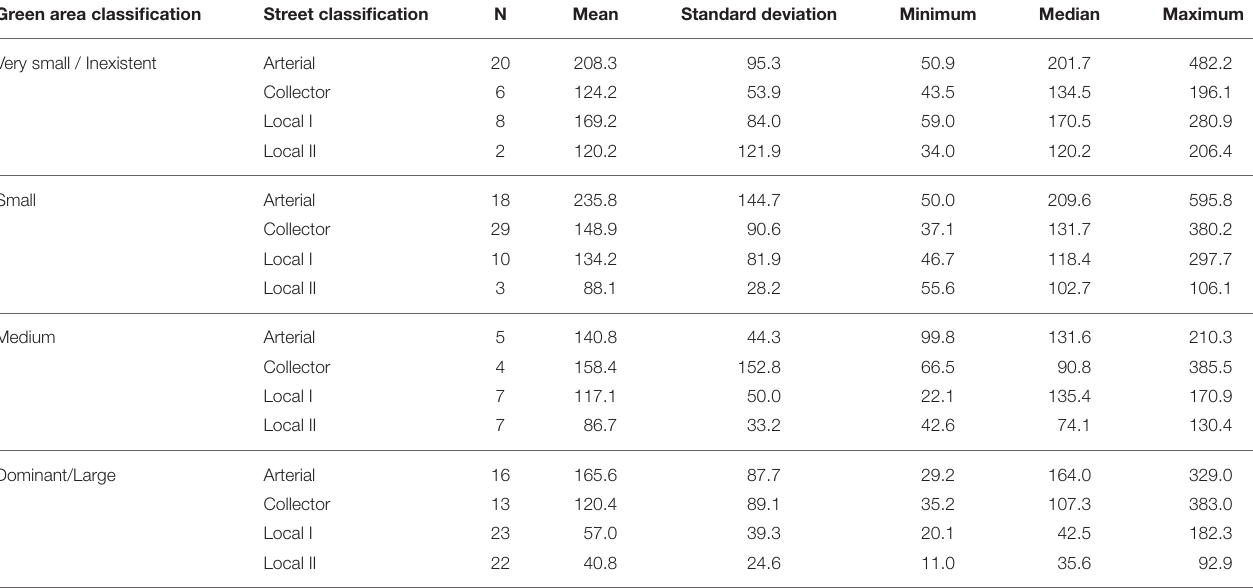
TABLE 1 | Descriptive statistics of Zn concentrations (mg kg − 1 ) in the barks of Tipuana tipu according to green areas size and street classification.